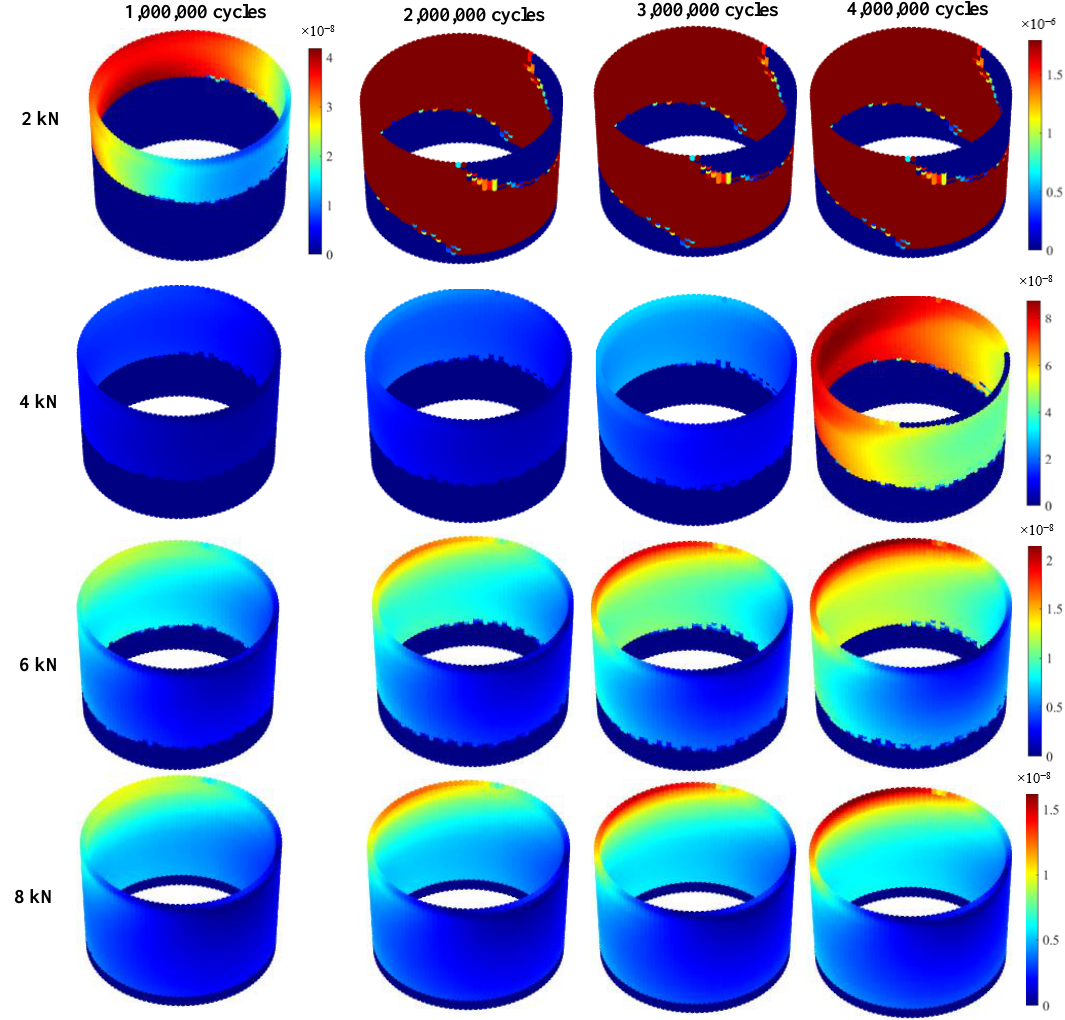
Figure 7. Micromotion profiles of the head-neck interface (Micromotions are presented in meter).